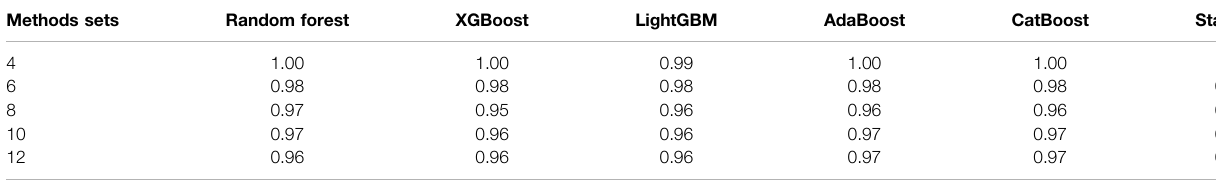
TABLE 3 | The accuracy of different classi fi ers for training sets of 140 curves per generating model. Methods sets